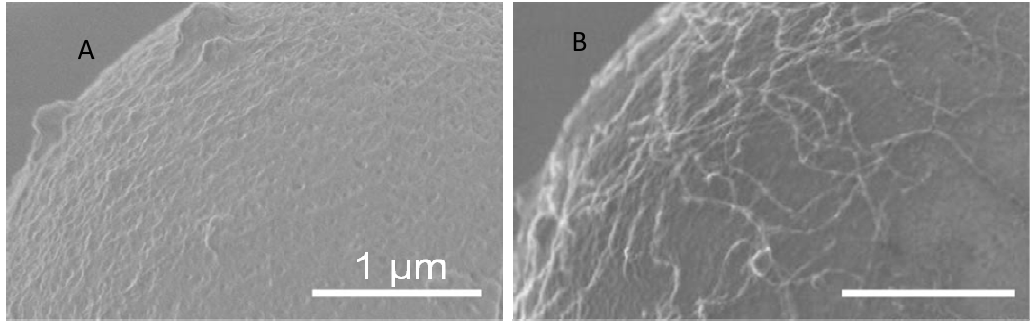
Figure 8. Decorating of the surface of a microsphere with CNT using CNT binding peptides. (A) Microsphere surface in the absence of CNT binding peptide and (B) adhesion of CNTs on CNT binding peptide decorated microsphere Reprinted by permission from Macmillan Publishers Ltd: Nature Materials [116], copyright